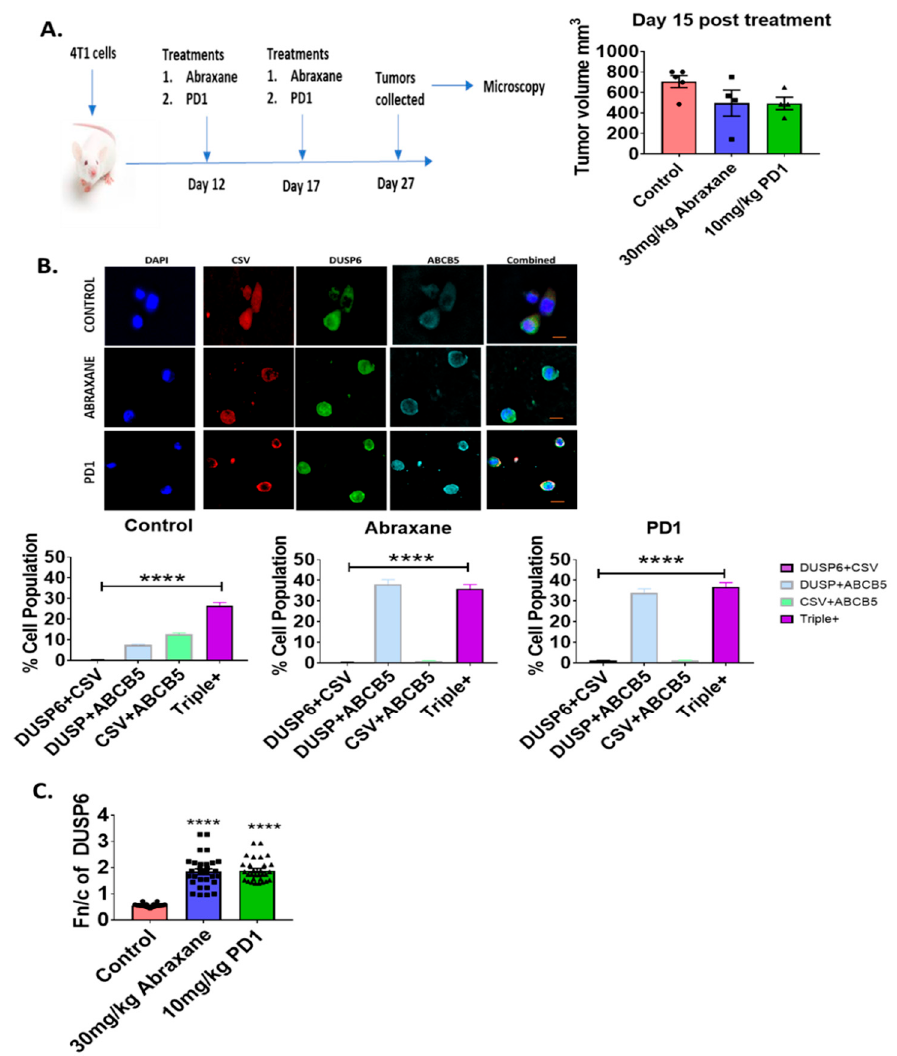
Figure 3. Nuclear-biased DUSP6 in the 4T1 metastatic mouse cancer model. ( A ) Treatment regimen using the BALB / c 4T1 breast cancer model and day 15 tumor volumes of mice treated with vehicle control, Abraxane, or PD-1 ( n = 4). ( B ) DUSP6 expression in the primary 4T1 tumor model. Fluorescence labelling of DUSP6, CSV, and ABCB5 was performed for ASI microscopy analysis. Bar graph represents cells double-positive for either DUSP6 / ABCB5 / CSV or triple-positive for these three markers. n = 3 mice per group ( > 500 cells per patient counted). Data represent mean ± SE. Unpaired t -test. **** p < 0.0001 denote significant di ff erences. Example images of each group are indicated with scale bars (10 µ m). ( C ) DUSP6 Fn / c (ratio of nuclear to cytoplasmic staining) was quantified in the primary 4T1 tumor model. Fn / c was determined by performing ASI microcopy analysis and using ImageJ-Fiji to determine the ratio. Bar graphs represent fn / c mean ± SE. Unpaired t -test., **** p < 0.0001 denote significant di ff erences. Example images are in 3B.